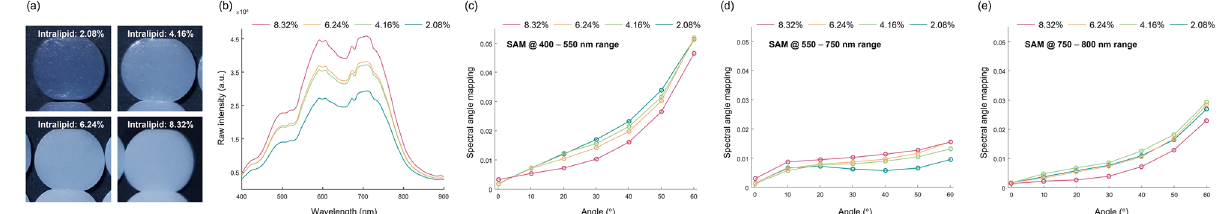
Figure 3. Assessment of angle-dependent spectral distortion by exploiting tissue-mimicking phantoms. ( a ) Photographs of a tissue-mimicking phantom with intralipid concentrations of 2.08%, 4.16%, 6.24%, and 8.32%. ( b ) Raw reflected signals from phantoms were measured at the normal position. Reflected signals showed high intensity as increasing intralipid concentrations. ( c – e ) SAM results of four tissue-mimicking phantoms were quantitatively analyzed at three different spectral regions (400–550 nm, 550–750 nm, and 750–800 nm),